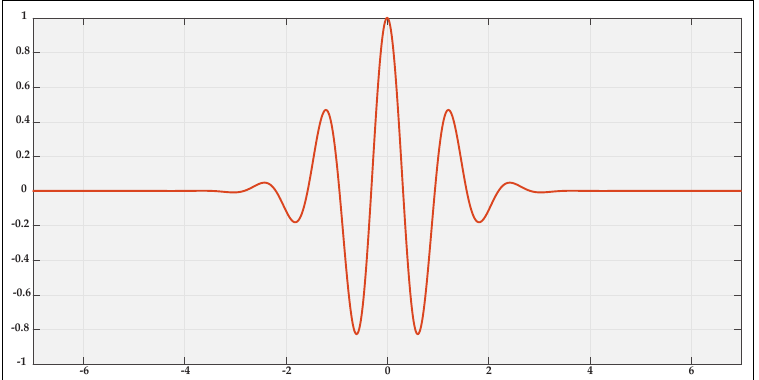
Figure 1. Prototypical example of a Morlet